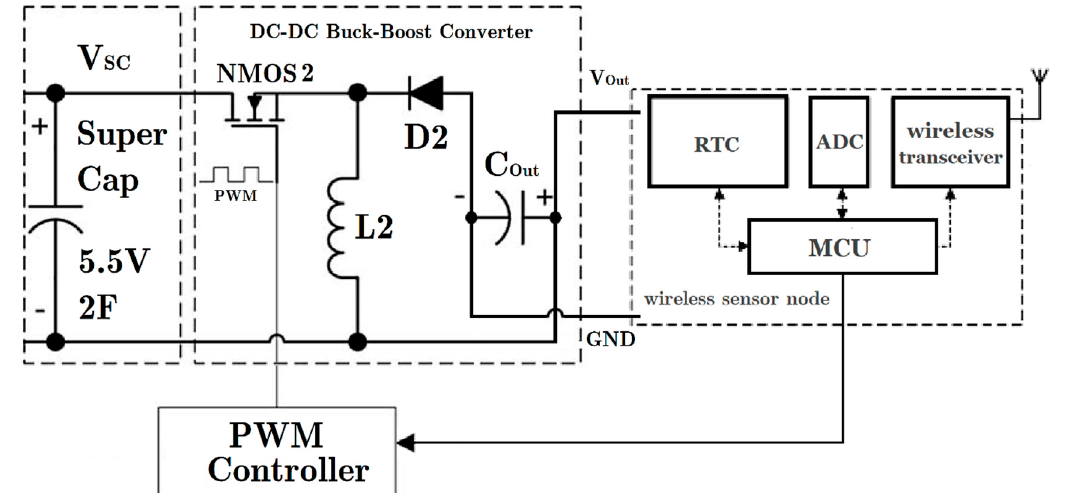
Figure 3. DC-DC Buck-Boost power supply circuit for wireless node.